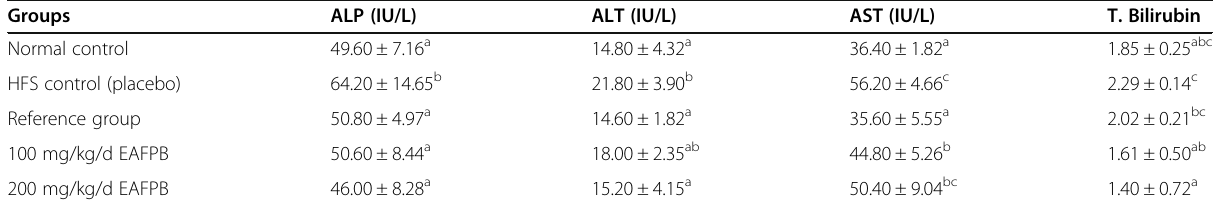
Table 4 Effect of EAFPB on some liver function parameters of fructose overloaded rats Groups